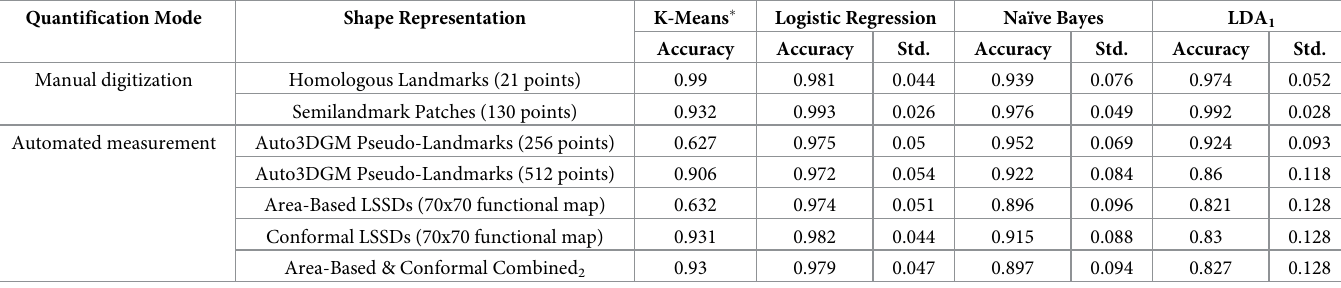
Table 1. Accuracies and standard deviations for hominoid group classification